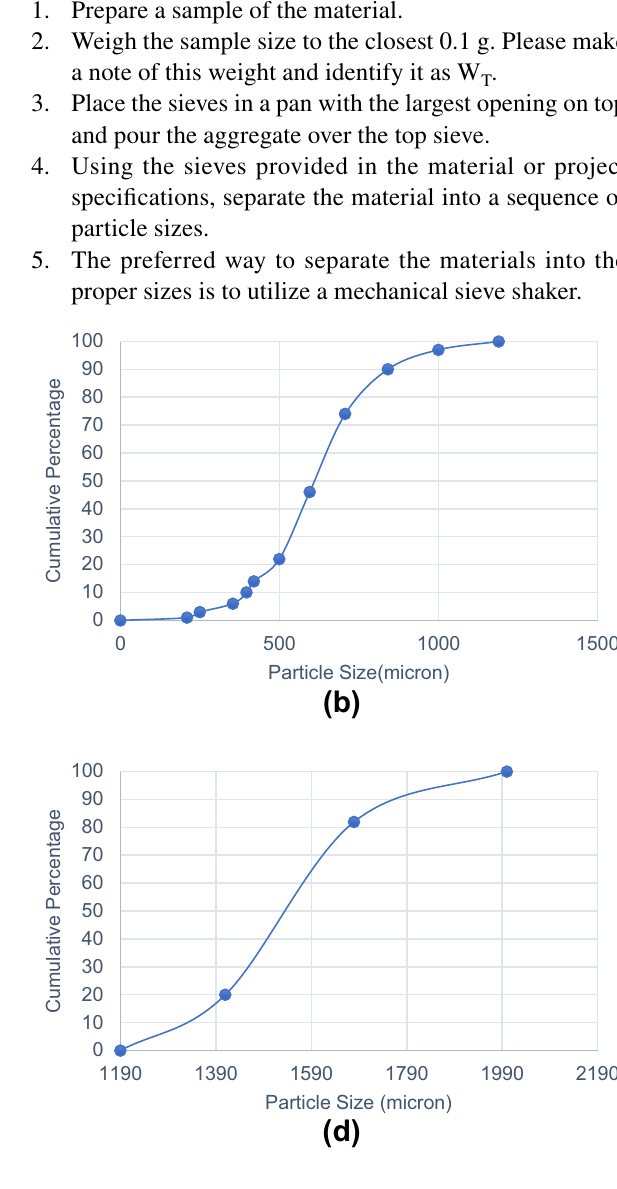
Fig. 7 a Wheat Straw particle size distribution (0–1190 micron). b Wheat Straw cumulative particle size distribution (0–1190 micron). c Wheat Straw particle size distribution (1190–2000 micron). d Wheat Straw cumulative particle size distribution (1190–2000